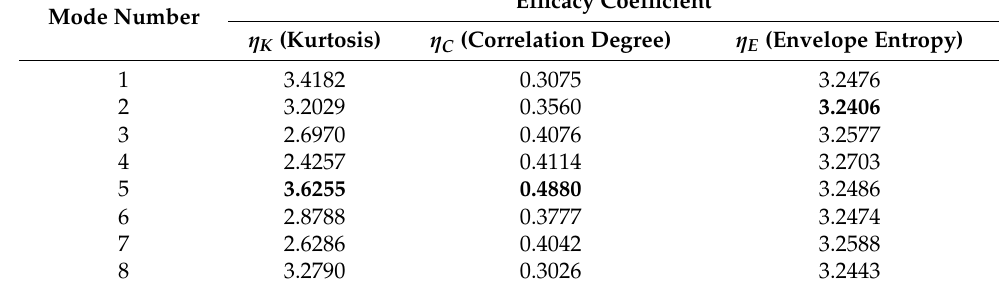
Figure 14. Changing curve of between the value of the objective function and the iteration num- Figure 15. Envelope spectrum of optimal component by using IVMD. ber.